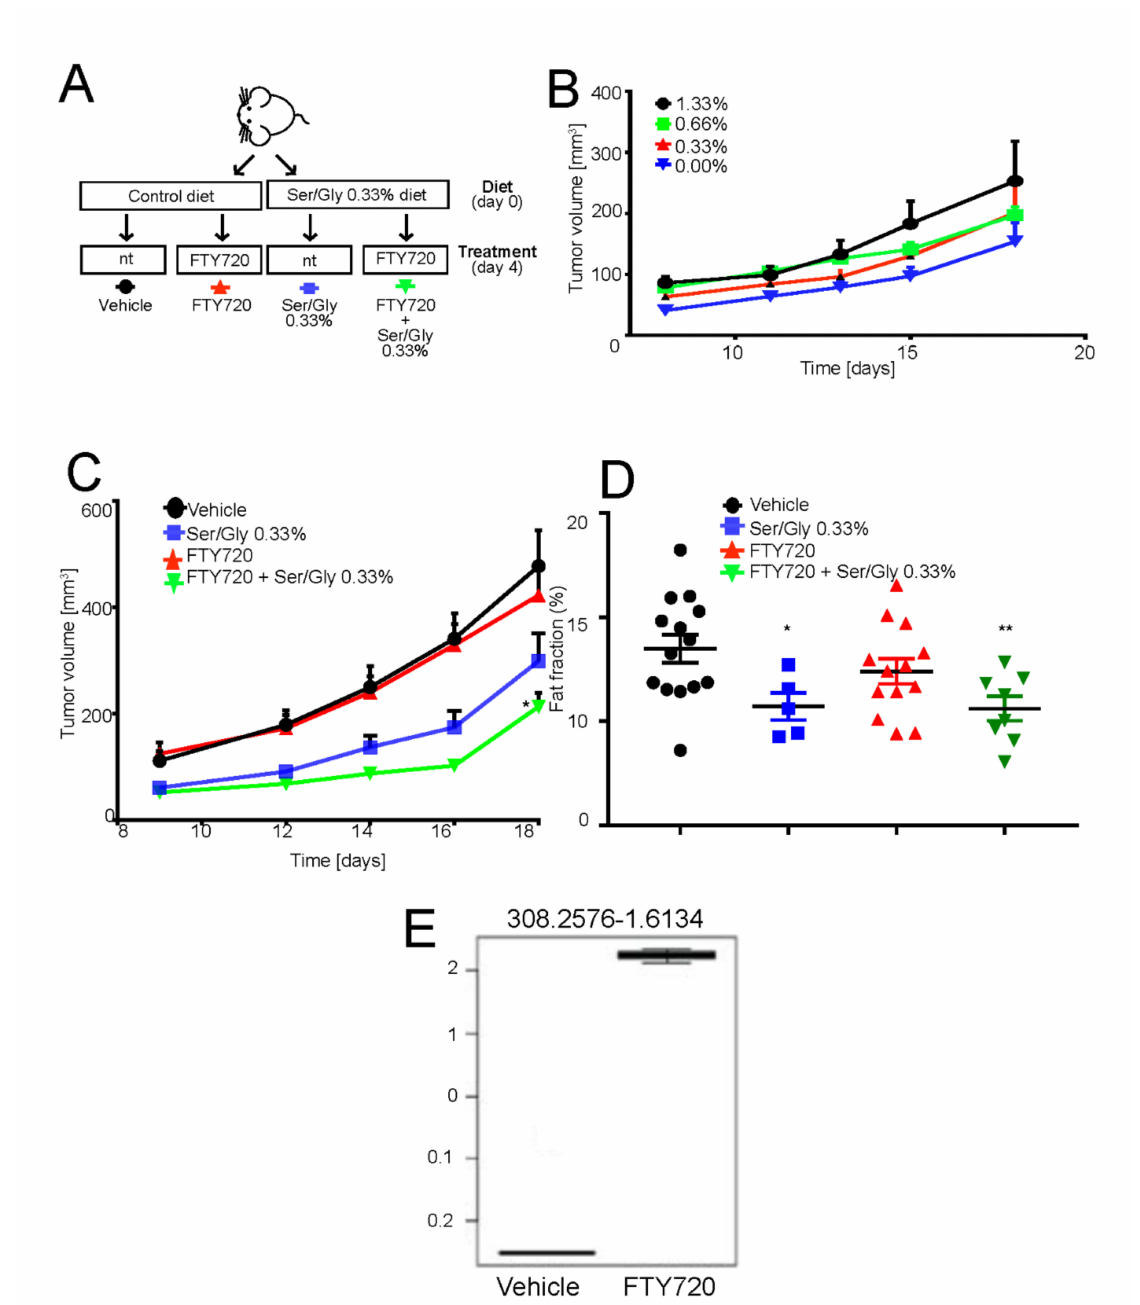
Figure 5. FTY720 in combination with low serine/glycine diet reduces tumor growth. ( A ) Schematic representation of the in vivo experiment. Mice were switched to normal or serine/glycine low diet at the time of subcutaneous 143B tumor implantation. Four days after injection, mice were intraperitoneally treated with 10 mg/kg of FTY720 on a 5 days on-2 days off basis. Tumor growth was monitored daily and mice were sacrificed at day 18 from injection; ( B ) Tumor volume in mice treated as on low serine/glycine diet, concentrations ranging from 0%, to 1.33%. Data are presented as the mean ± S.E.M. of n = 14 mice from 3 independent experiments; unpaired two-tailed Mann-Whitney test; * p < 0.05 vs vehicle; ( C ) Tumor volume of mice treated as in panel A. Data are presented as the mean ± S.E.M. of n = 14 mice from 3 independent experiments; unpaired two-tailed Mann-Whitney test; * p < 0.05 vs. vehicle; ( D ) Plot showing the calculated magnetic resonant imaging (MRI)-fat fraction inside the tumor region for the four investigated groups; ( E ) FTY720 quantification in tumor samples harvested 18 days from implantation, with treatment regimen described in Figure 5E, by LC-MS/MS untargeted lipidomic profiling ( n = 7